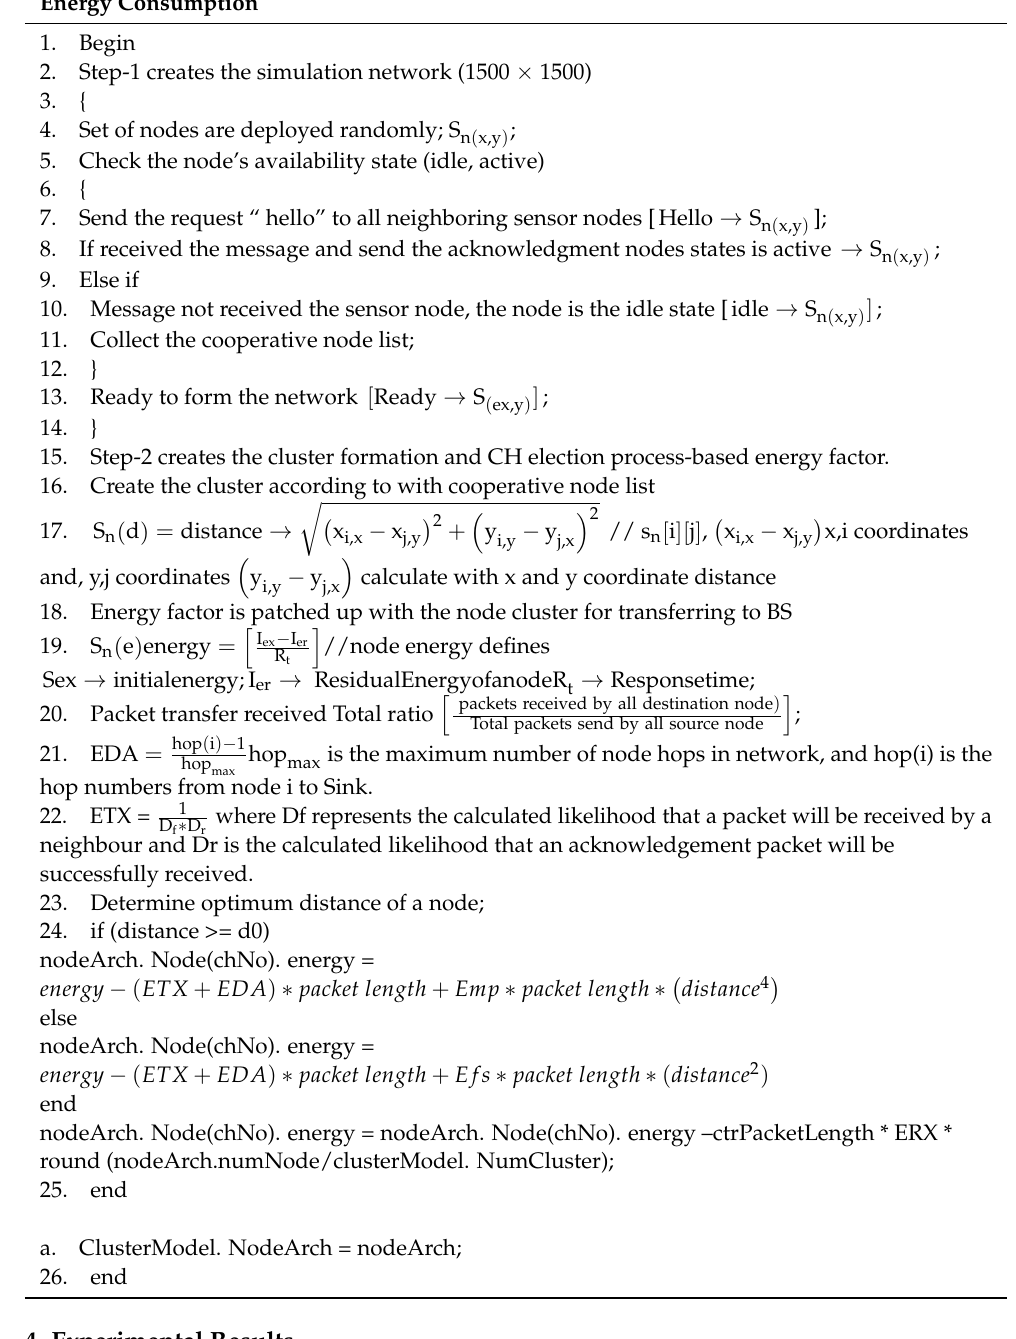
Algorithm 2: for Secure Encryption Random Permutation Pseudo Algorithm (SERPPA)